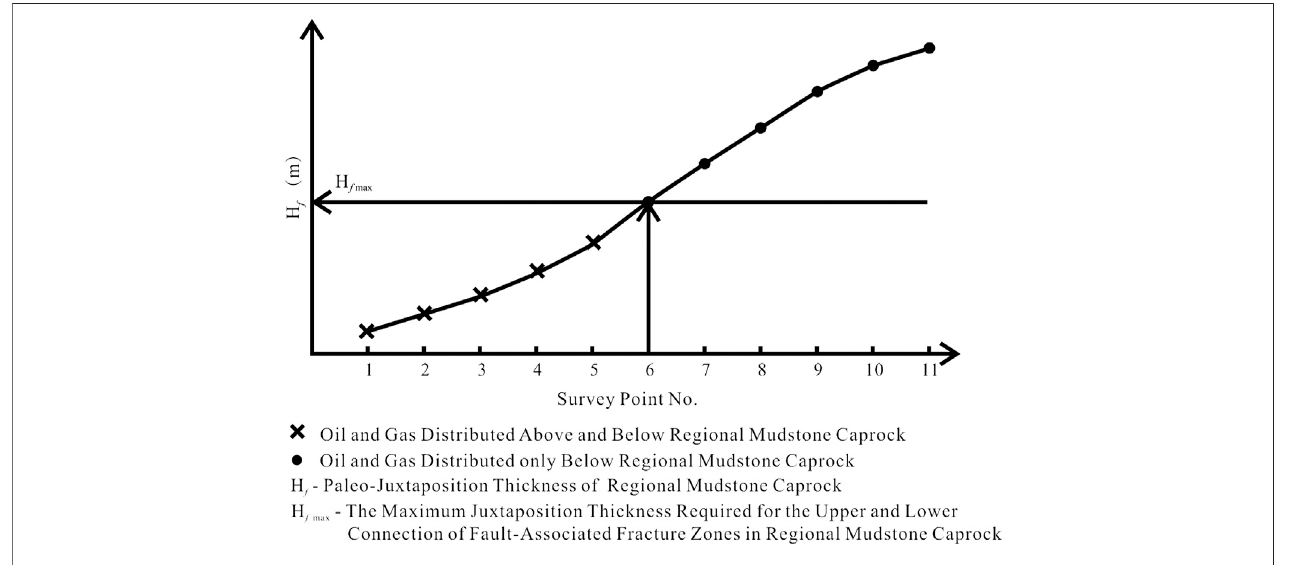
FIGURE6| Diagramofthedeterminationofthemaximumjuxtapositionthicknessrequiredfortheupperandlowerconnectionofthefault-associatedfracturezone in regional mudstone caprock.